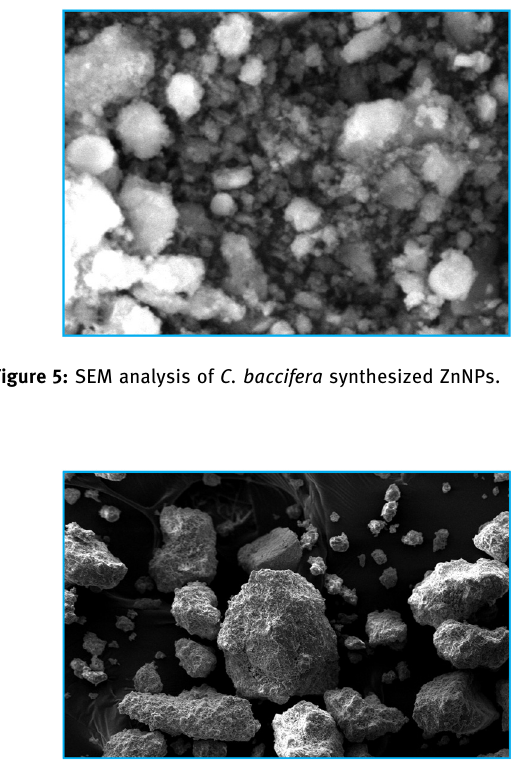
Figure 6: TEM analysis of C. baccifera synthesized